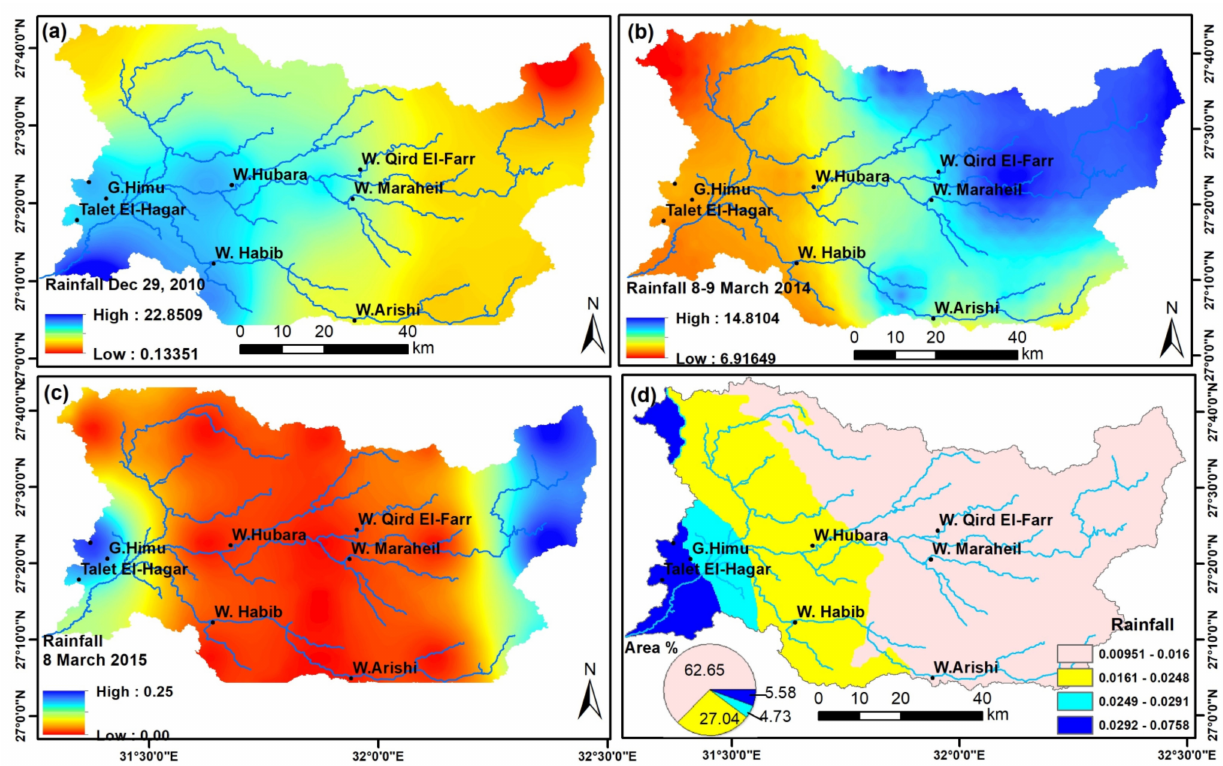
Figure 7. Precipitation data (mm/day) covering Wadi Asyuti: ( a ) Kriging distribution of precipitation following the storm on 29 December 2010, ( b ) distribution of precipitation on 8 to 9 March 2014; ( c ) precipitation on 8 to 9 March 2015, ( d ) average precipitation (years 1998–2015) in Wadi